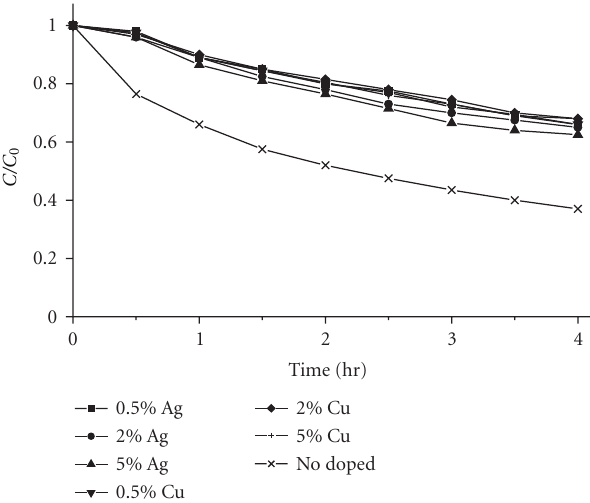
Figure 9: Relationship of the Cr(VI) removal rates on the photocatalytic reduction by modified TiO 2